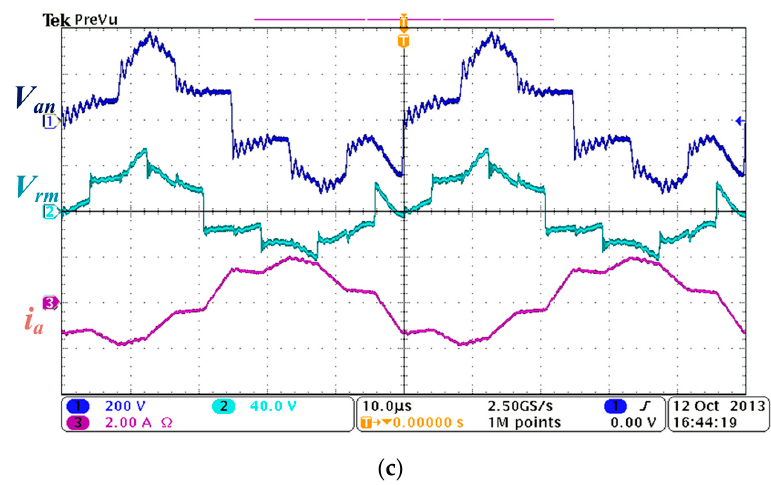
Figure 8. Steady ‐ state waveforms. ( a ) Trapezoidal modulation with 1 A charging current; ( b ) Phase ‐ shifted modulation with 10 A charging current; ( c ) Phase ‐ shifted modulation with 10 A discharging current.